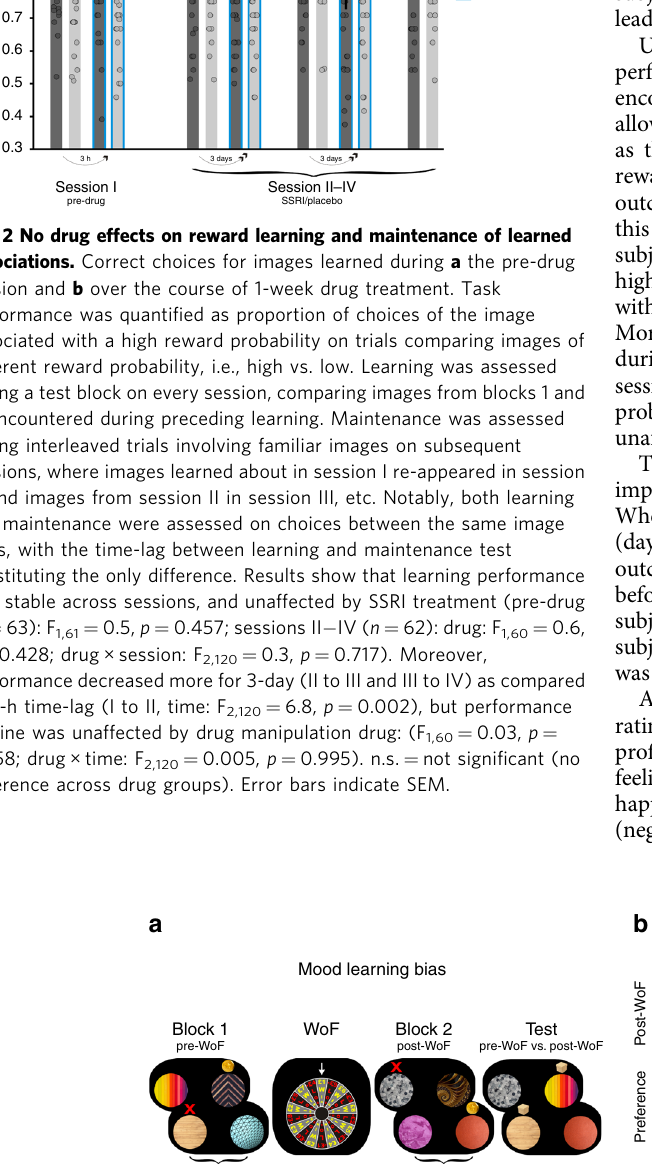
Fig. 3 SSRIs induce an impact of positive mood on learning. a Each session comprised two learning blocks, where subjects encountered four novel images, two with a high (70%) and two with a low reward probability (30%). Feedback enabled subjects to learn about images ’ reward probabilities through trial-and-error. Additionally, sessions II and IV comprised a WoF draw between learning blocks, where each subject either won (yellow) or lost (red) a large monetary amount (£7 − £9). After the second learning block, subjects performed a test choice block, where they chose between images from the two preceding learning blocks. To prevent further learning, outcomes were not revealed in these test blocks, and subjects were instructed to rely solely on what they had learned previously about the images. b Proportion of test block choices between images encountered during preceding learning with feedback in different blocks, i.e., pre-WoF or post-WoF. This analysis compared choices between images with equal reward probabilities, i.e., high vs. high and low vs. low, and preference is computed as difference between percent choices of post-WoF images and pre-WoF images, as a function of WoF outcome. Participants showed a preference for images encountered in better mood, favouring post-WoF images after a winning draw, and favouring pre- WoF images after a losing draw. The SSRI group showed a signi fi cantly positive mood bias (F 1,32 = 12.1, p = 0.001), and it was enhanced as compared to placebo subjects (F 1,60 = 5.5, p = 0.021, n = 62). ** p < 0.01, * p < 0.05. Error bars indicate SEM. c Interaction between affect and reward sensitivity. Rewards impact on emotional state, which, in turn, impacts on perception of subsequent rewards. In this bidirectional interaction, SSRIs enhance the impact of positive affect on reward sensitivity. This serotonergic effect can engender a positive feedback loop.